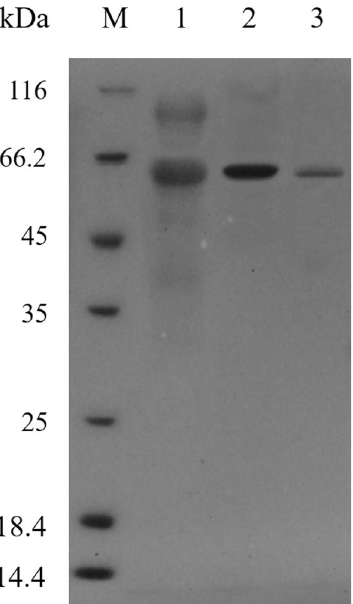
Figure 3. SDS-PAGE analysis of the purification of the recombinant enzyme CapA. M: Protein molecular weight standard; 1: crude enzyme solution; 2: purified CapA by Ammonium sulfate precipitation and dialysis; 3: purified CapA by Q-Sepharose anion-exchange column chromatography.